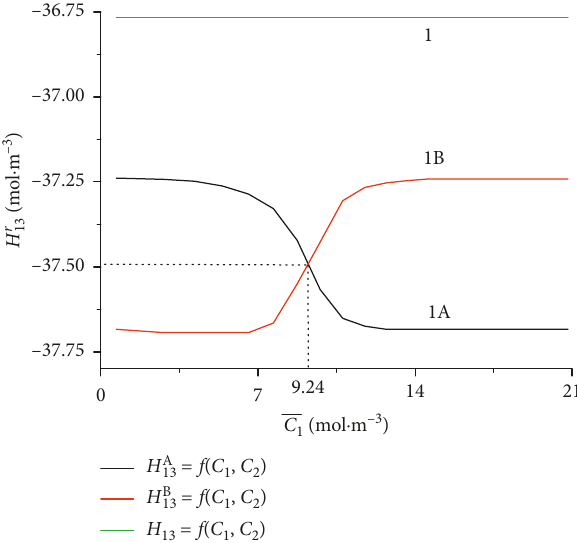
3 aqueous Figure 4: The graphic illustration of the dependence H r A and B ( r B)) of the 3 ), ( r 37.71mol m A , B ) for the glucose in aqueous ethanol − (cid:31) (cid:31) (cid:31) · (cid:31) solution in conditions of concentration polarization for configu- − rations A ( H A f ( C 1 , C 2 const.), curve 1A) and B ( H B 13 (cid:31) (cid:31) C 2 (cid:31) const.), curve 1B) of the membrane system. Line 1 illustrates f ( C 1 , C 2 const.) for conditions of homo- the dependence H 13 (cid:31) (cid:31) geneity of solutions.